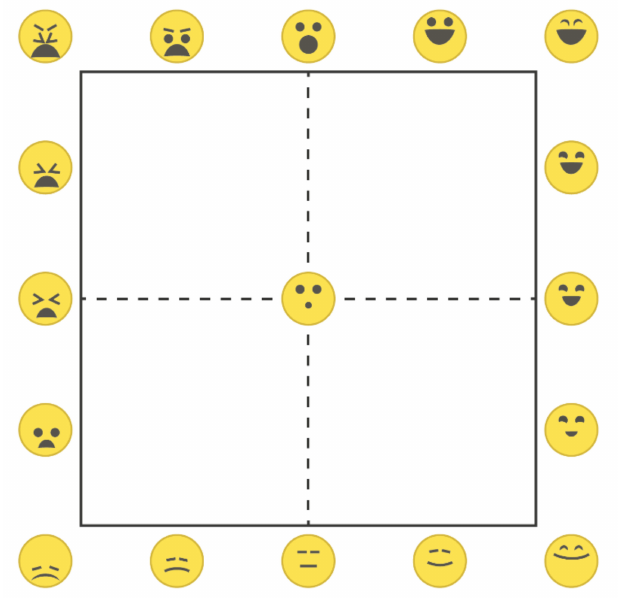
Figure 1. The EmojiGrid (from [20], see also https://en.wikipedia.org/wiki/EmojiGrid, (accessed on 4 March 2022). The x-axis represents the valence rating, whereas the y-axis represents the arousal rating, both on a scale from